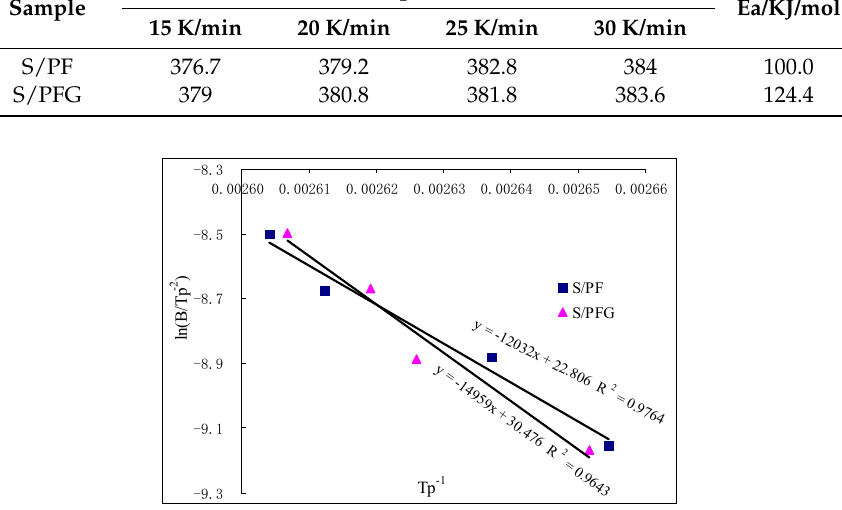
Table 8. The Tp obtained from the DSC spectra and the calculated Ea for samples S/PF and S/PFG. Sample